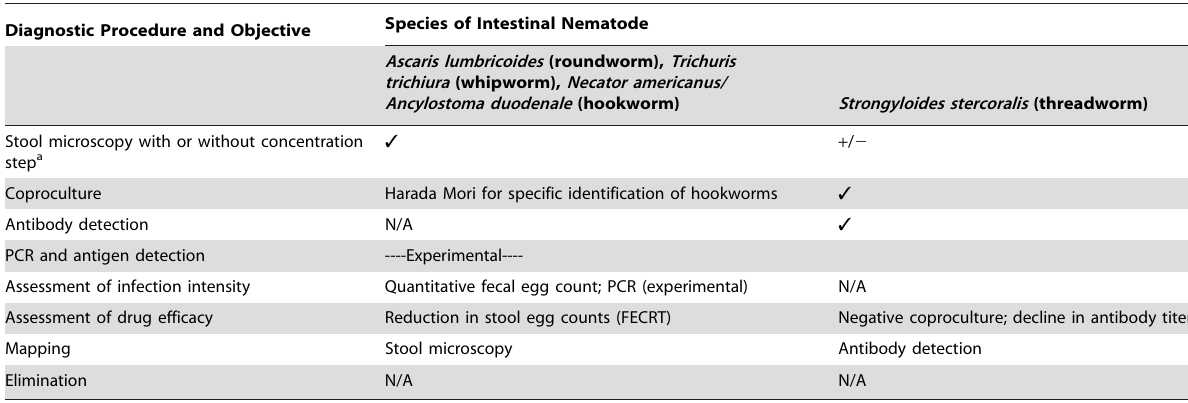
Diagnostic Procedure and